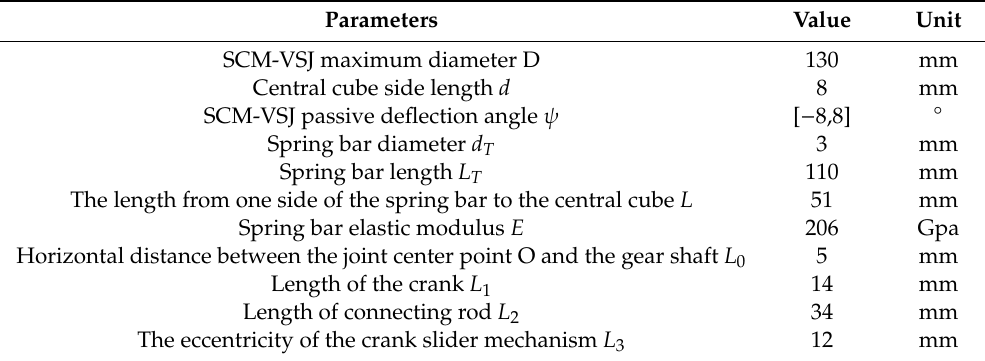
Table 2. Parameters of